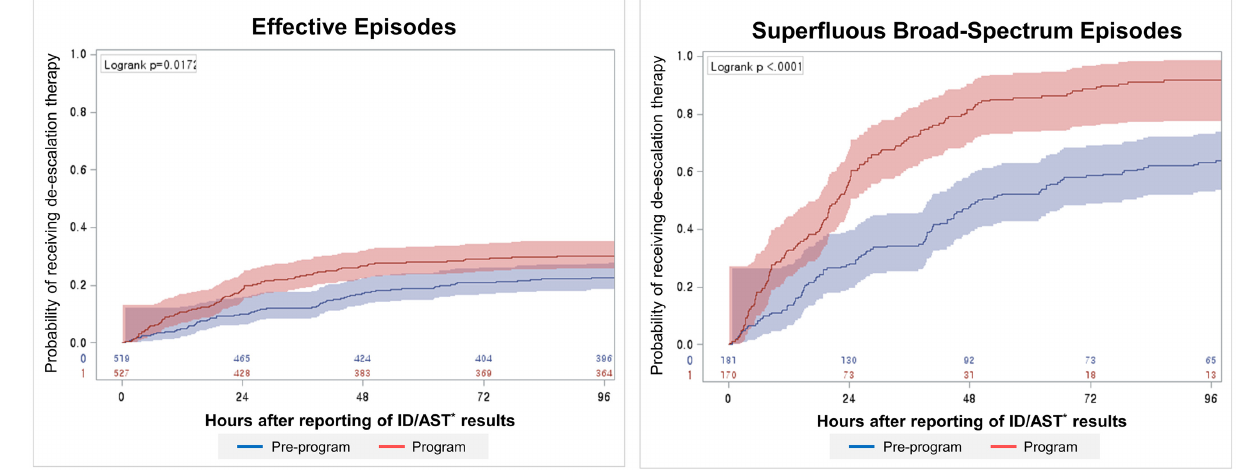
Fig 4. Kaplan-Meier curve of the time to de-escalation therapy * Identification and Antimicrobial susceptibility test.